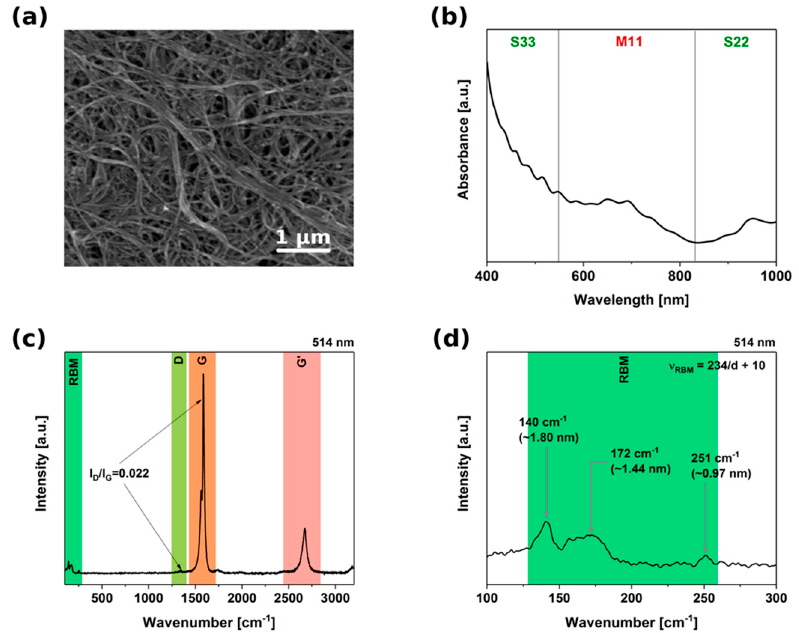
Figure 2. Characterization of the starting material. ( a ) Scanning Electron Microscopy (SEM) micrograph, ( b ) absorbance spectrum, ( c ) Raman spectrum, ( d ) close-up plot of Radial Breathing Mode (RBM) area from the Raman spectrum (514 nm excitation).